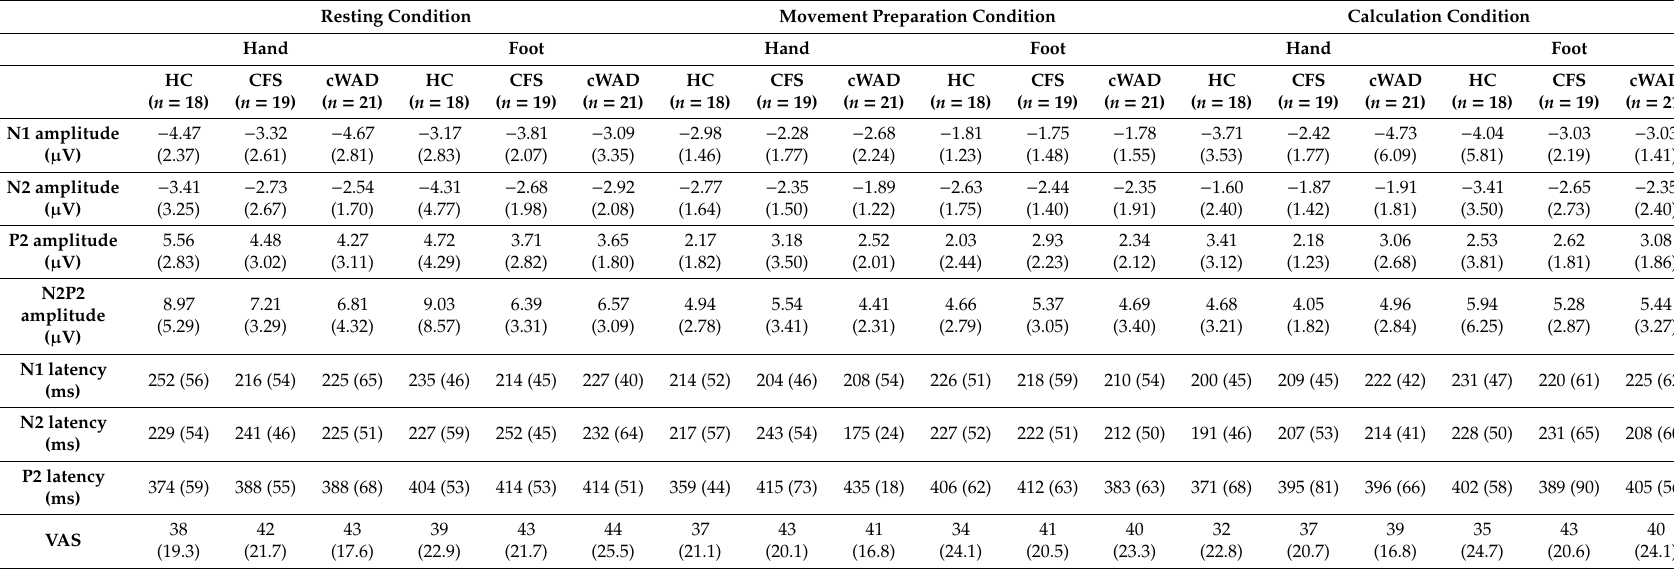
Table 2. LEP latencies, amplitudes and VAS ratings, separated by type of condition, location and population for nociceptive laser stimulation. Resting